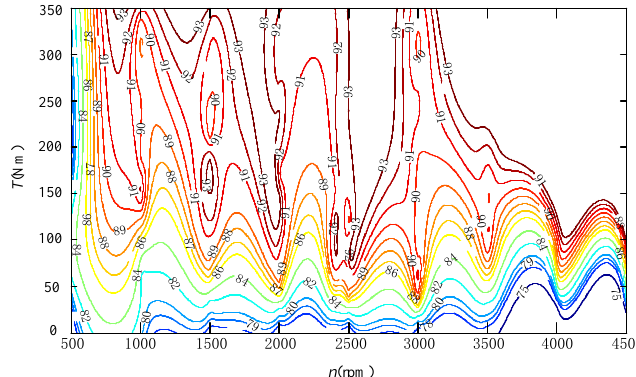
Figure 9. Efficiency diagram of drive system in collaborative optimization control mode.